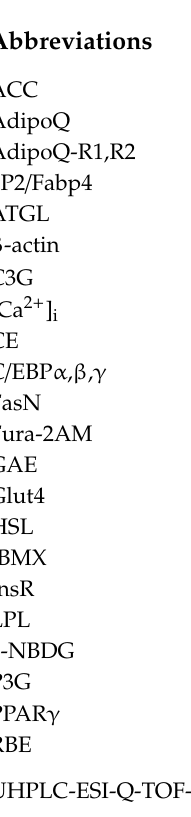
Figure S1: Extracted ion chromatogram of phytochemical compounds detected in Riceberry rice extract (RBE) obtained by UHPLC–ESI-Q-TOF-MS / MS in negative and positive ion mode, Table S1: List of primers for RT-qPCR, Table S2: MS and MS / MS data of phytochemical compounds detected in Riceberry rice extract (RBE) obtained by UHPLC–ESI-Q-TOF-MS / MS in negative mode, Table S3: MS and MS / MS data of phytochemical